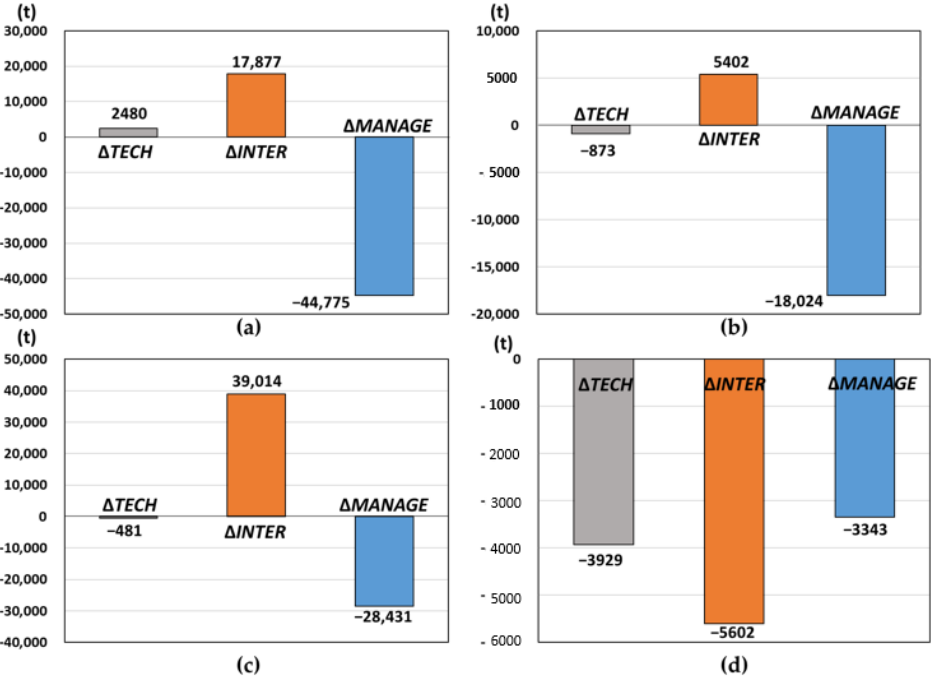
Figure 9. Breakdown of efficiency change effects for the LARGE group in the ( a ) east, ( b ) central, ( c ), west, and ( d ) northeast regions.